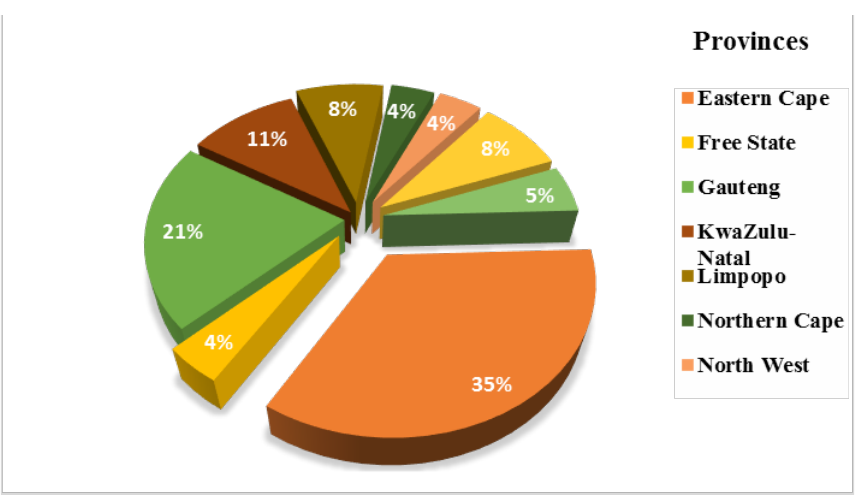
Figure 2. Chart showing the percentage of HEV study in different province of South African